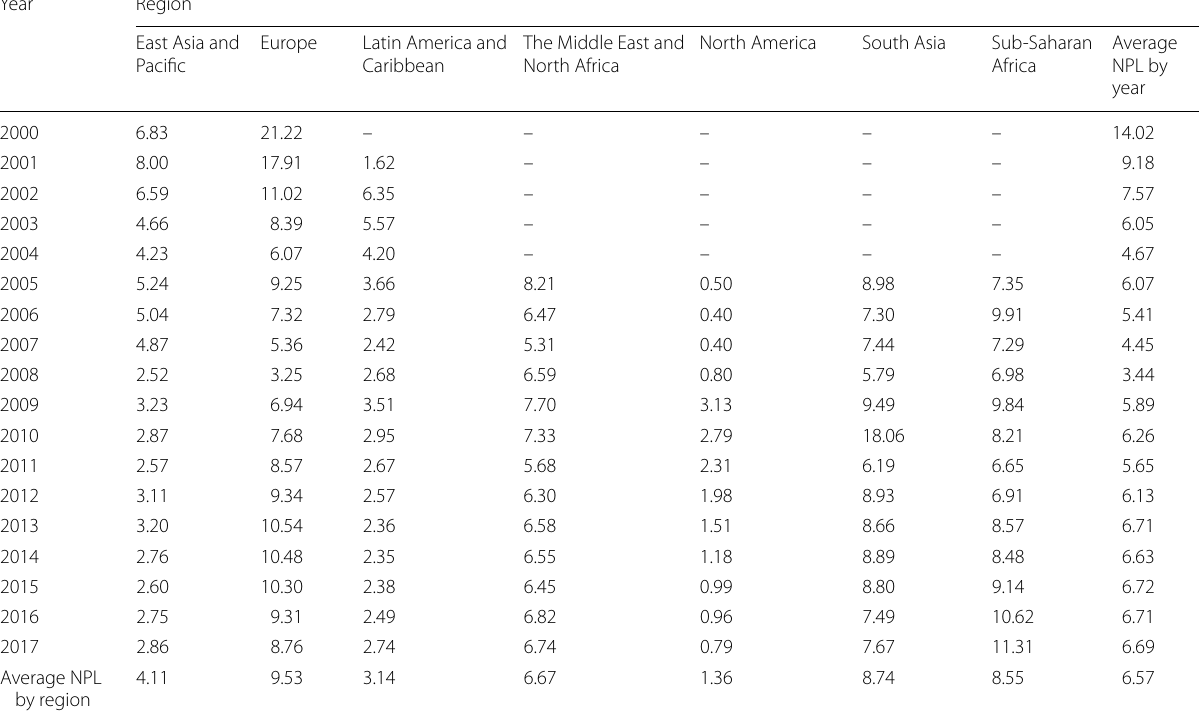
Bank nonperforming loans to total gross loans are the value of nonperforming loans divided by the total value of the loan portfolio (including nonperforming loans before the deduction of specific loan-loss provisions). The loan amount recorded as nonperforming should be the gross value of the loan as recorded on the balance sheet, not just the overdue